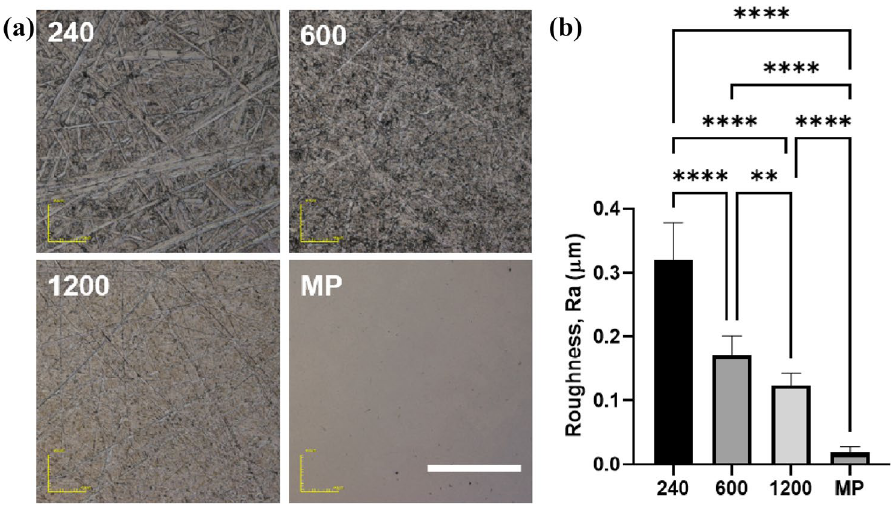
Figure 1. Confocal laser microscopic images ( a ) and surface roughness, Ra ( b ) of disordered abrasive scratches on Ti surface. The scale bar indicates 100 μm. The data shown are mean ± SD. **p < 0.01; ****p <